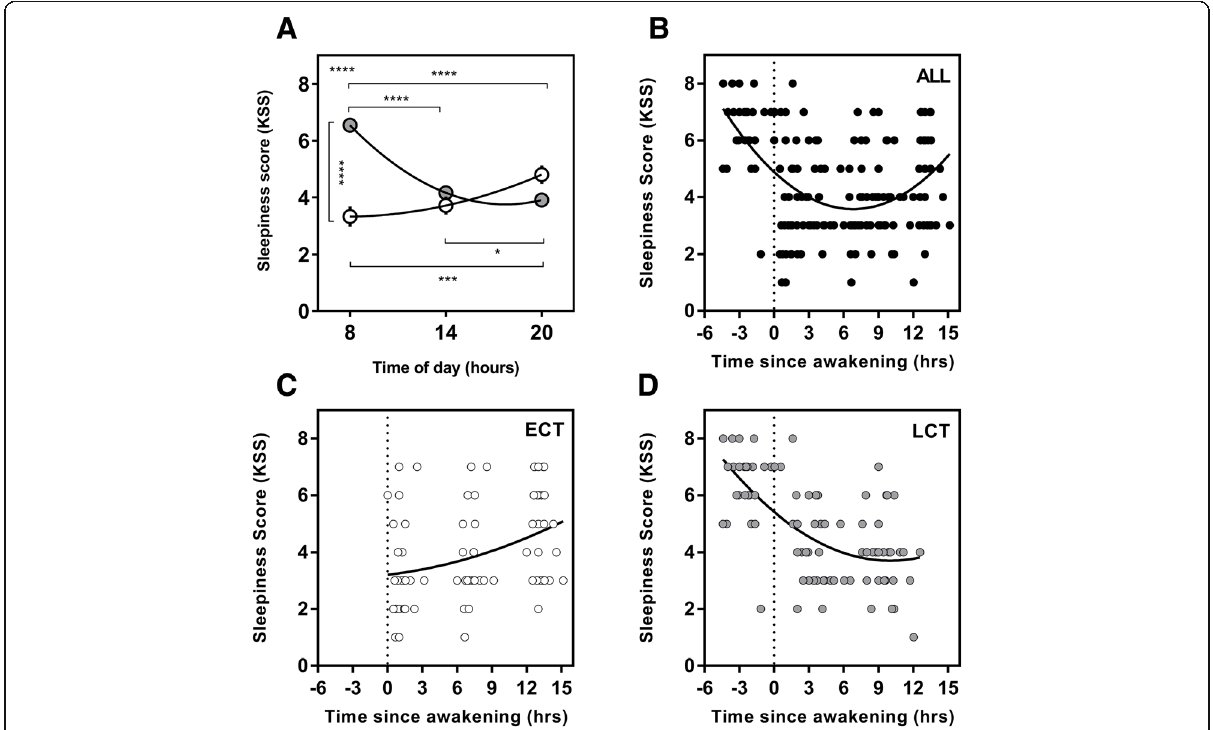
Fig. 1 Diurnal variation in daytime sleepiness (KSS) and sleepiness as a function of time since awakening. Clock time variation ( a ) in KSS between ECTs (white circles) and LCTs (grey circles). KSS as a function of time since awakening for all subjects ( n = 56; b ), ECTs ( n = 25; c ), LCTs ( n = 31; d ). Entrained wake-up time, i.e. biological time 0, is shown with the dotted line. Curves are second-order polynomial non-linear regressions. The significance is shown as * = p < 0.05, ** = p < 0.01, *** = p < 0.001, **** p < 0.0001. The result shown in the upper left of ( a ) plots represents the interaction between the time of day and chronotype derived from the overall two-way ANOVA. Post hoc test results are shown with lines and asterisk between the time of day and chronotype